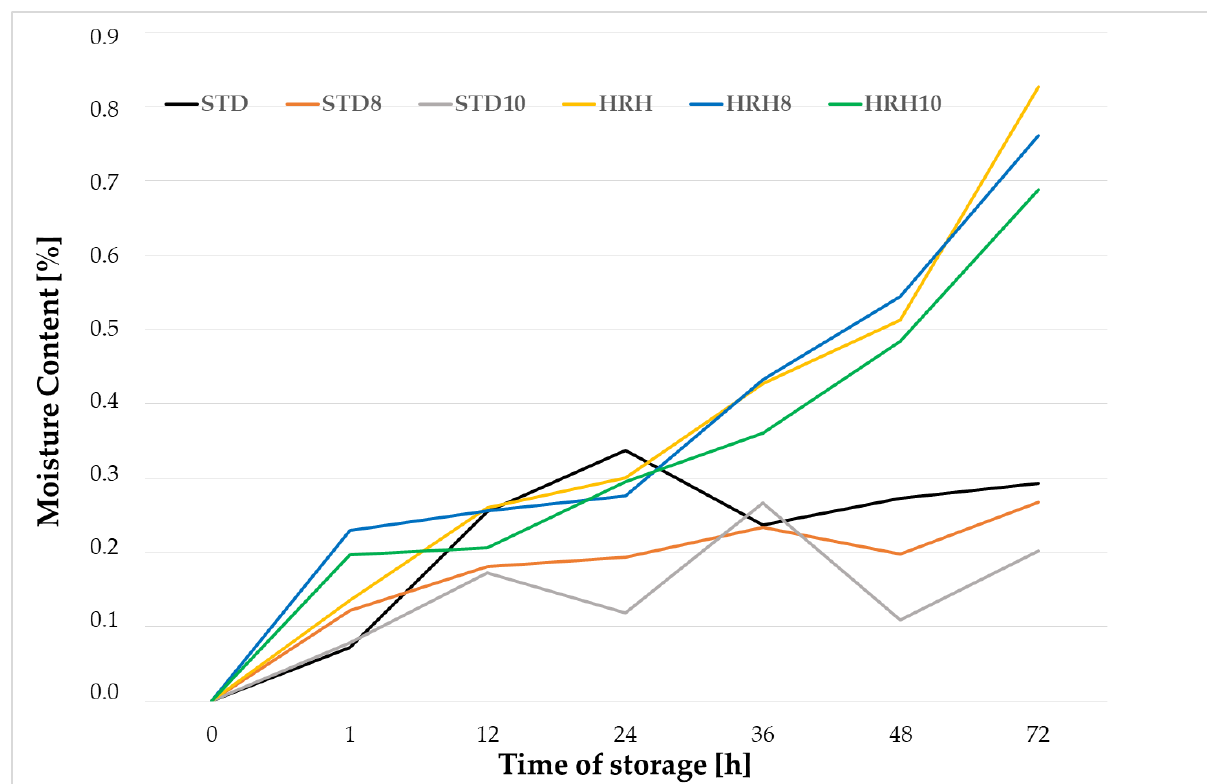
Figure 6. Moisture content of cores depending on the time of storage under different storage conditions (different shooting pressures used within the core production): STD—Laboratory ambient conditions—RH = 60% ± 5%, t = 25 ◦ C, Shooting pressure 6 bar; STD8—Laboratory ambient conditions—RH = 60% ± 5%, t = 25 ◦ C, Shooting pressure 8 bar; STD10—Laboratory ambient conditions—RH = 60% ± 5%, t = 25 ◦ C, Shooting pressure 10 bar; HRH—High relative humidity, constant temperature—RH = 90% ± 5%, t = 25 ◦ C, Shooting pressure 6 bar; HRH8—High relative humidity, constant temperature—RH = 90% ± 5%, t = 25 ◦ C, Shooting pressure 8 bar; HRH10—High relative humidity, constant temperature—RH = 90% ± 5%, t = 25 ◦ C, Shooting pressure 10 bar.